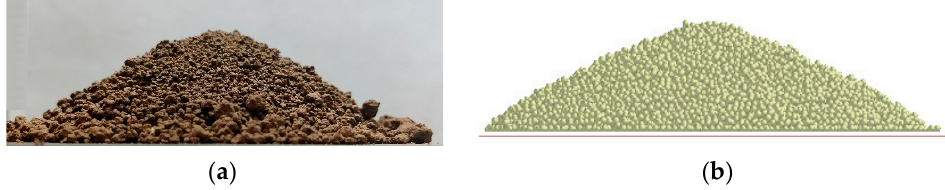
Figure 7. Comparison diagram of the soil repose angle between actual test and simulation test: ( a ) measured test results and ( b ) simulation test results. Table 4. Simulation test design of the soil repose